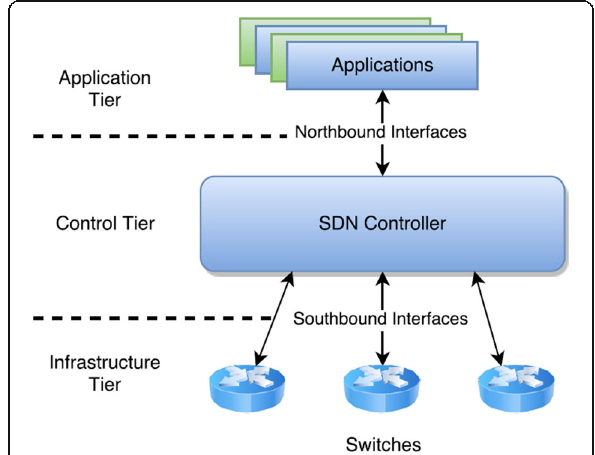
Fig. 6 SDN architecture. The SDN network architecture has three tiers: the application tier, the control tier, and the infrastructure